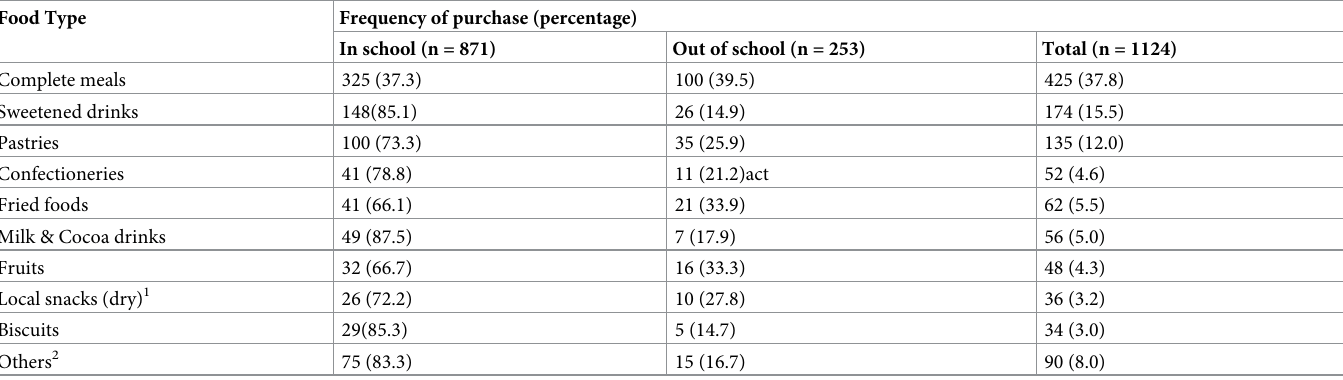
Table 2. Frequency of pupil purchases during mid-morning break period by source of